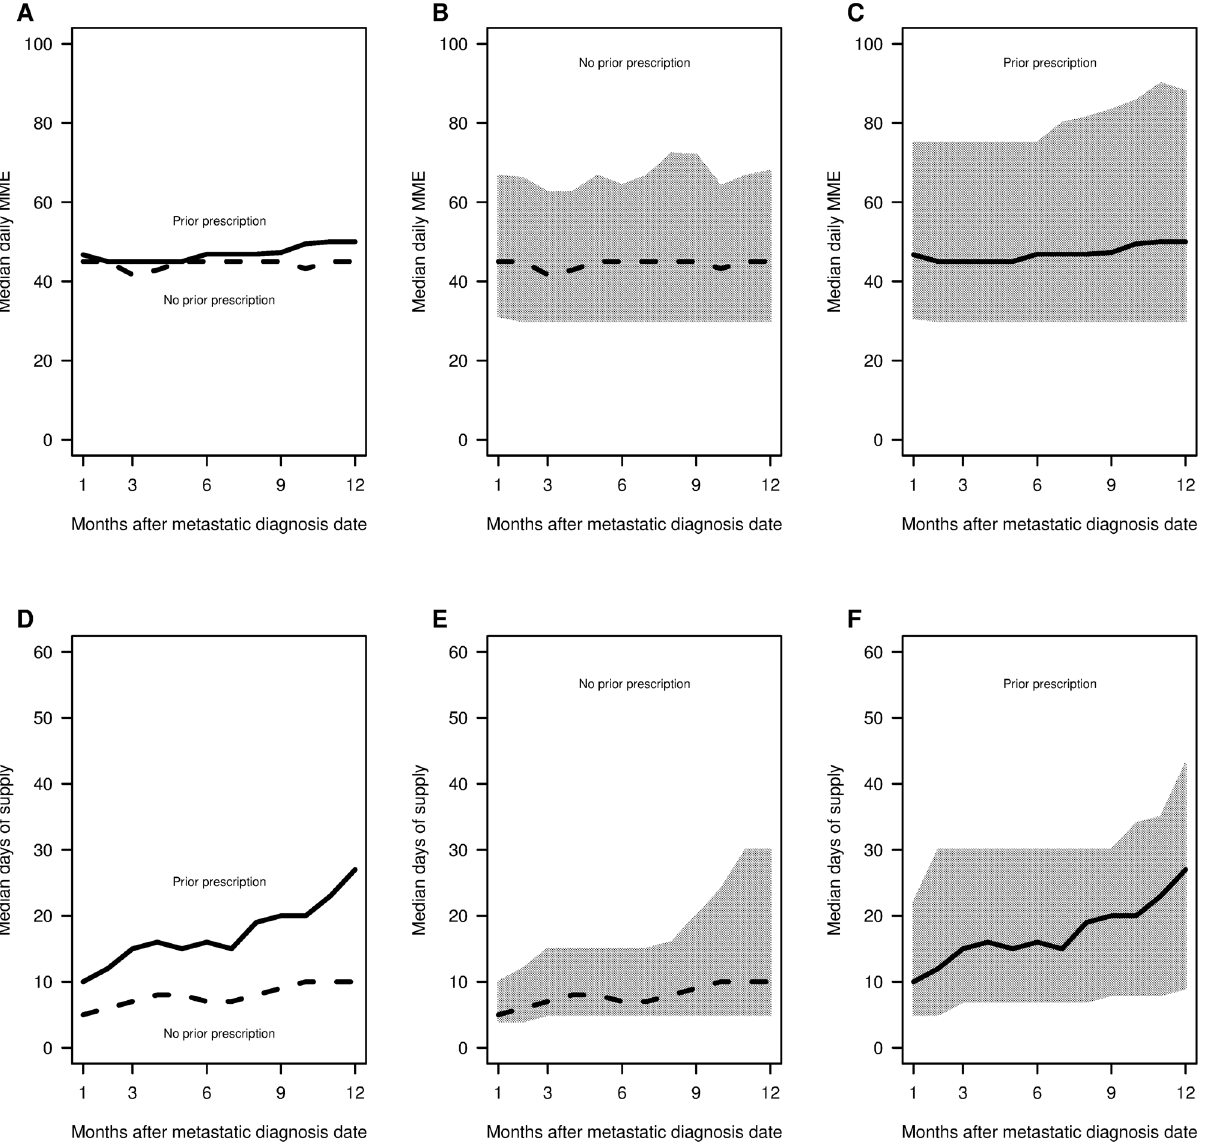
Figure 5. Median daily MME and median days of supply by month (left panel) after the metastatic diagnosis date stratified by any previous opioid use among patients who filled a prescription in the month. The rightmost panels show the respective IQRs. Using R software (https ://www.R-proje